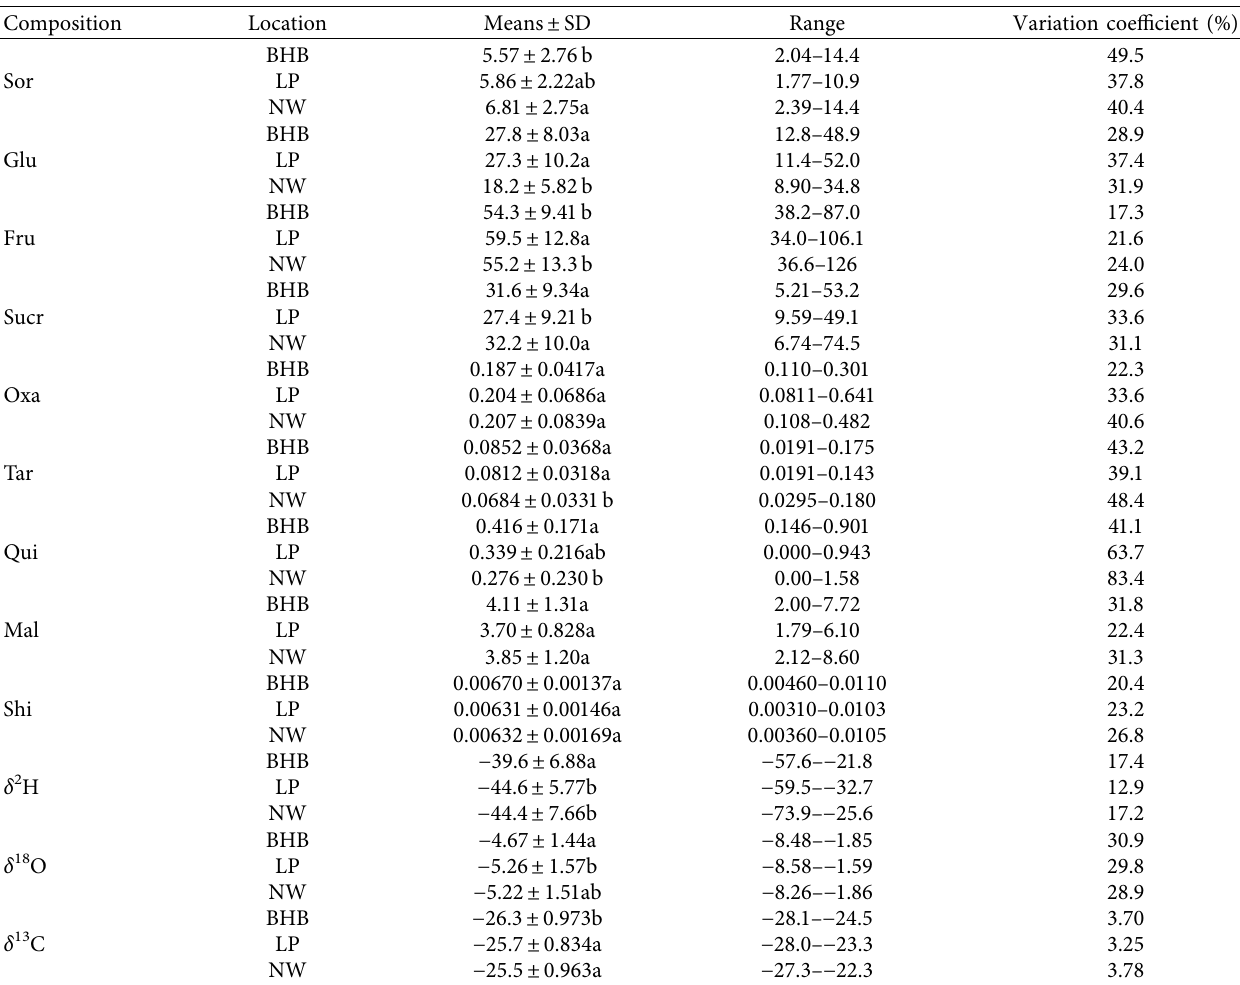
Table 2: Analysis of the regional differences of soluble sugars, organic acids, and stable isotopes in samples.